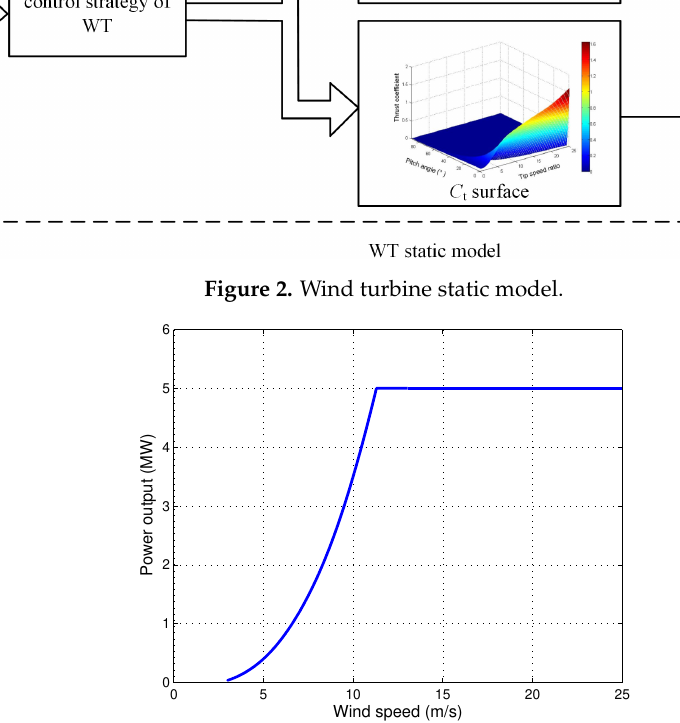
Figure 3. Power curve of the wind turbine in the non-down-regulation